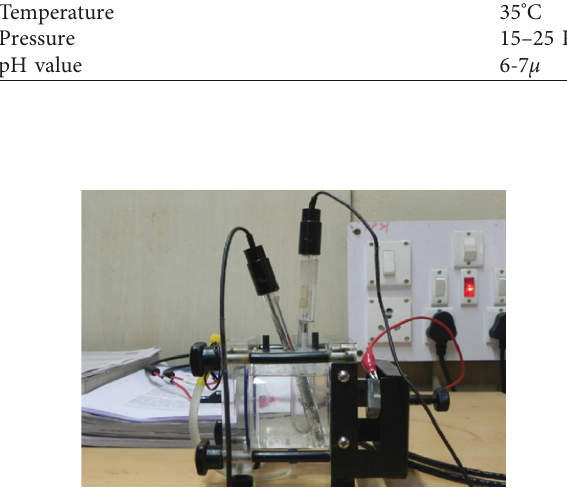
Figure 4: Polarization and impedance testing set up.